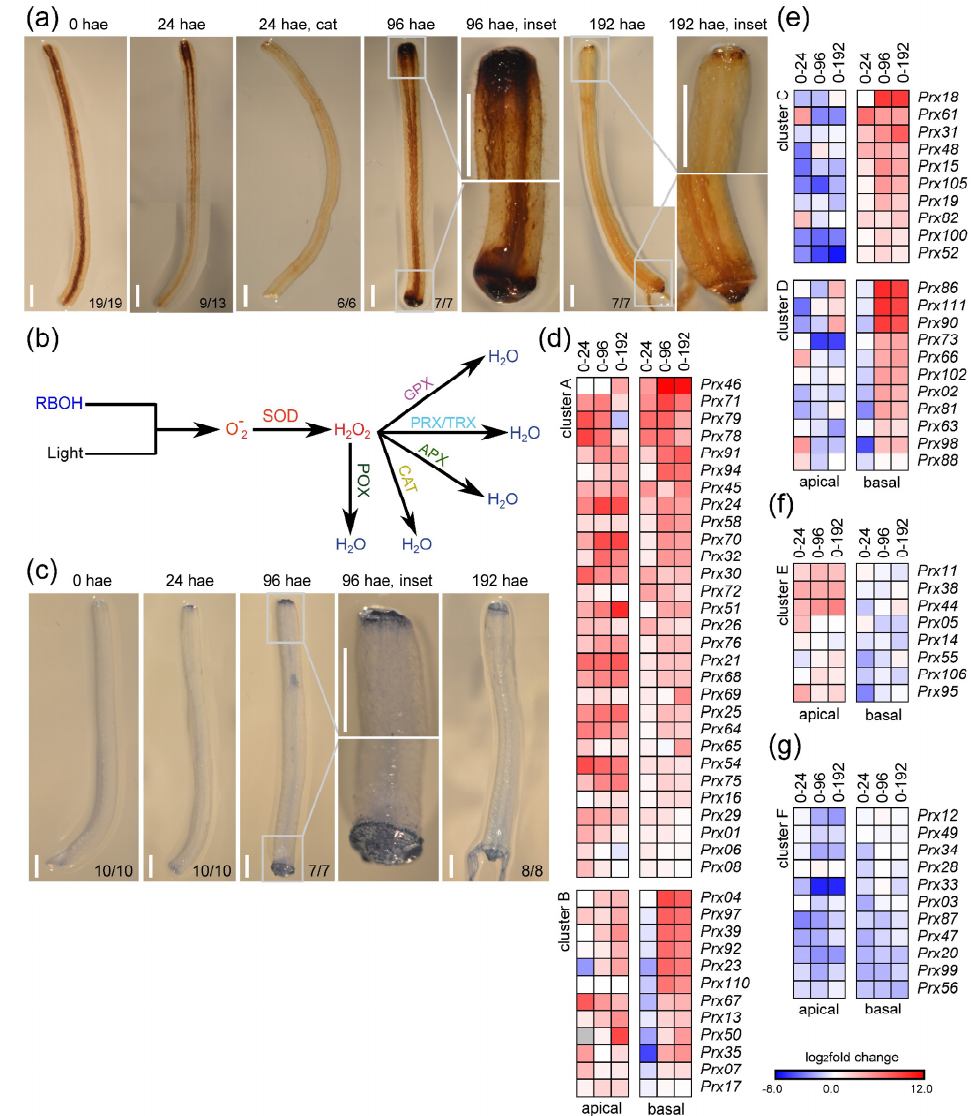
Figure 7. Regulation of ROS production during de novo organ formation. ( a ) H 2 O 2 accumulation visualized by DAB staining in hypocotyl explants over time. ( b ) Proposed pathways of ROS production and detoxification with the indicated key enzyme activities: RBOH, NADPH oxidase/respiratory burst oxidase homologue; SOD, superoxide dismutase; POX, peroxidase; GPX, glutathione peroxidase; PRX/TRX, peroxiredoxins/thioredoxins; APX, ascorbate peroxidases; CAT, catalases. ( c ) Localized cell death in hypocotyl explants was visualized by trypan blue staining. ( d – f ) Hierarchical clustering of DEGs encoding class III peroxidases. Blue/white/red in ( d – g ) indicate normalized cpm values in each row, where red indicates the highest abundance of transcripts. Gene annotations are found in Table S6. Scale bars ( a , c ): 3 mm.